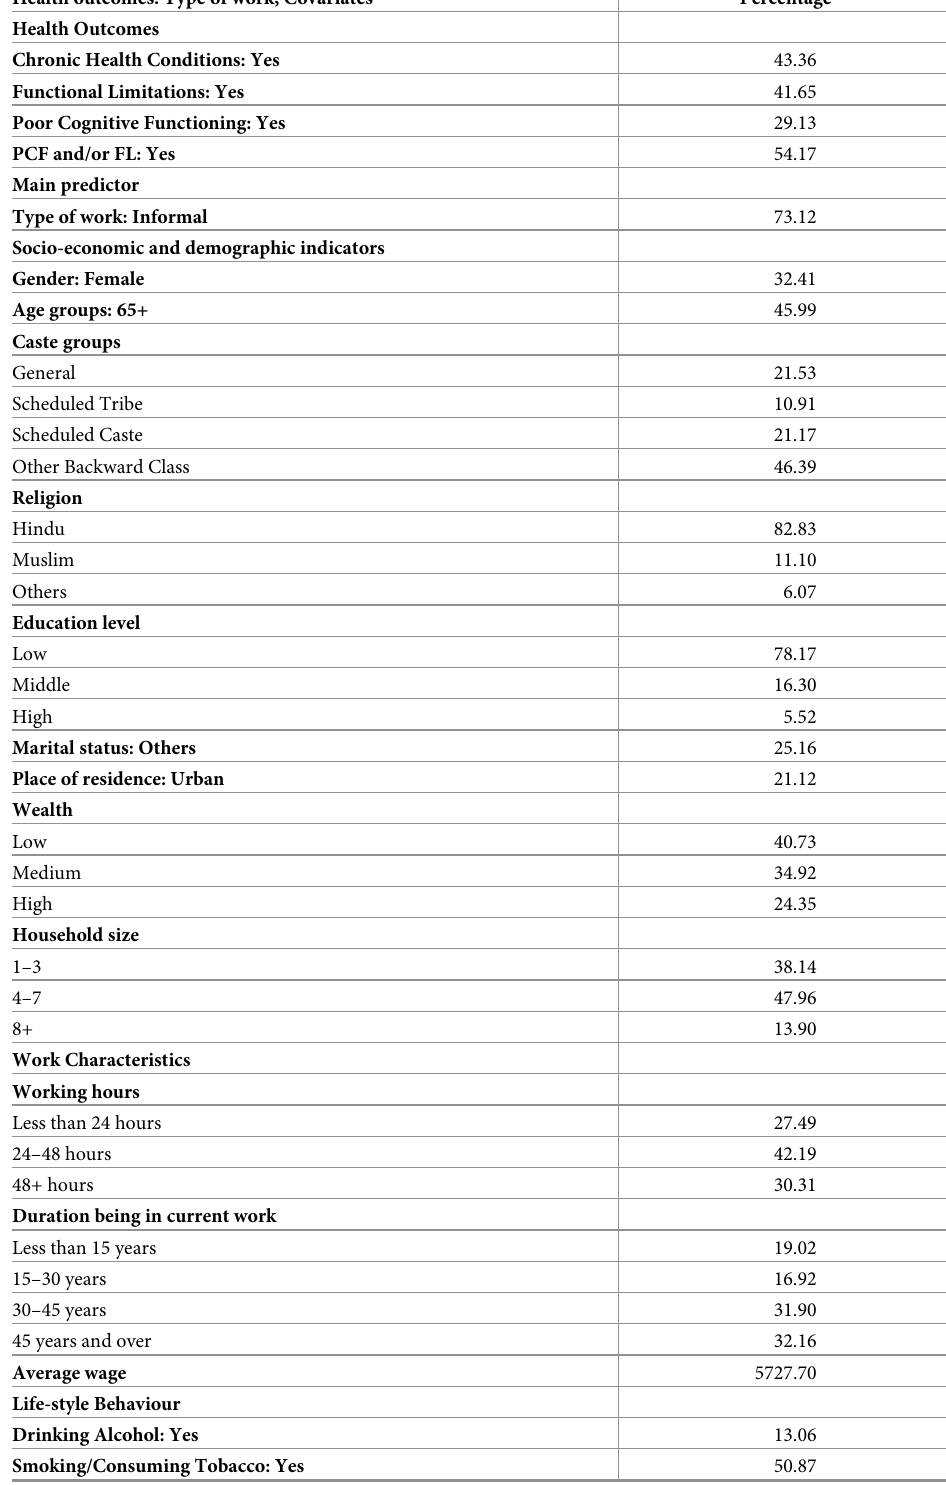
Table 2. Background characteristics of older workers (60 years and above), N = 10,746